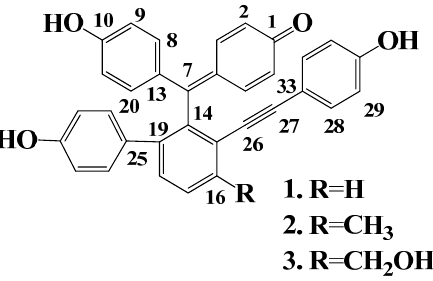
Figure 1. Structures of selaginellin derivatives from S. tamariscina .